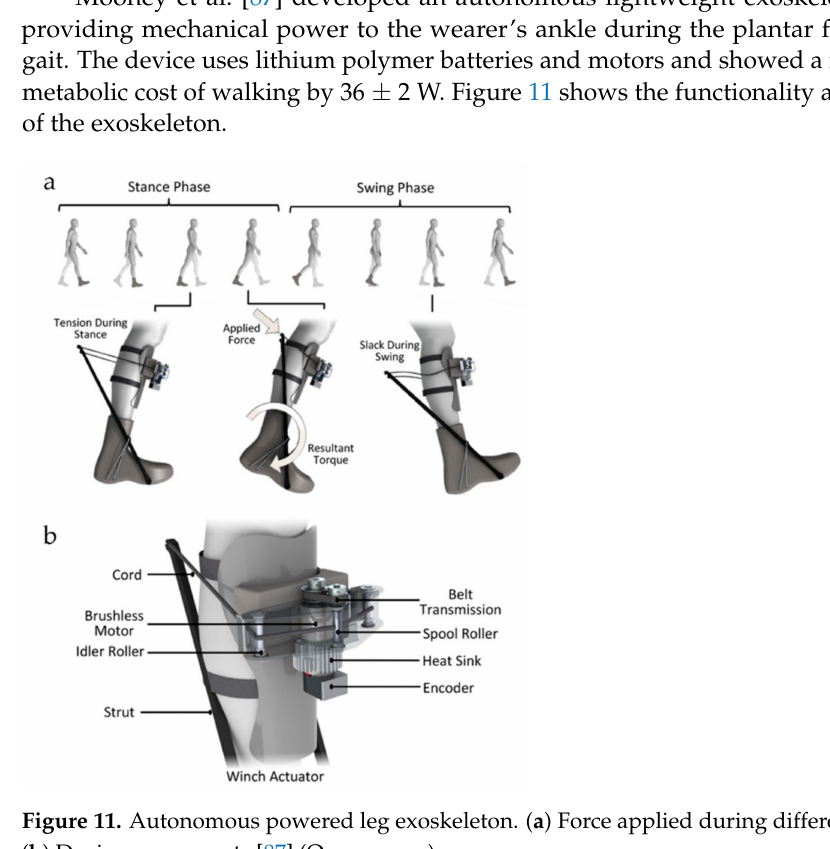
Figure 10. Components of the soft knee device [14] (Open access).